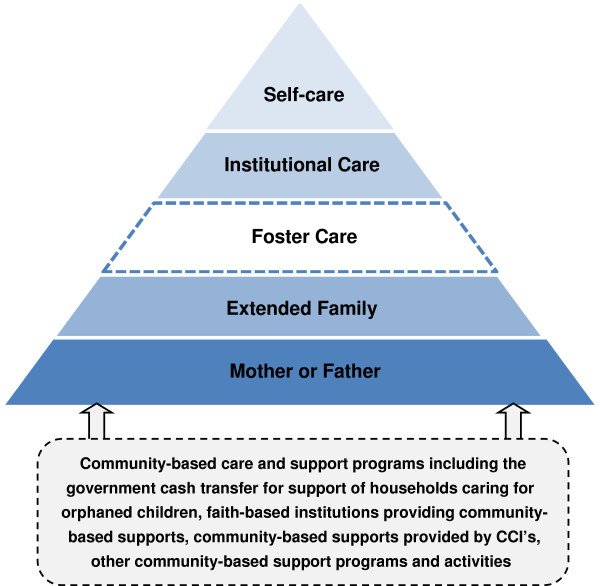
Proposed hierarchy of models of care for orphaned and separated children. Models in dotted lines represent opportunities for strengthening family-based care environments.